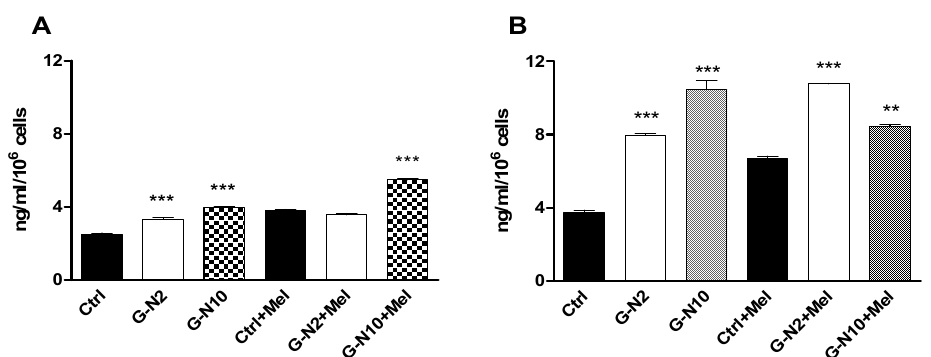
Figure 5. Osteocalcin assay. The graphs show the osteocalcin levels measured in hDPSC culture media after 14 days in both growth medium (GM) (panel ( A )) and differentiation medium (DM) (panel ( B )). The data derived from three different experiments (each n = 3) are expressed in ng/ml/10 6 cells as means ± standard deviation (** p < 0.001; *** p < 0.0001).